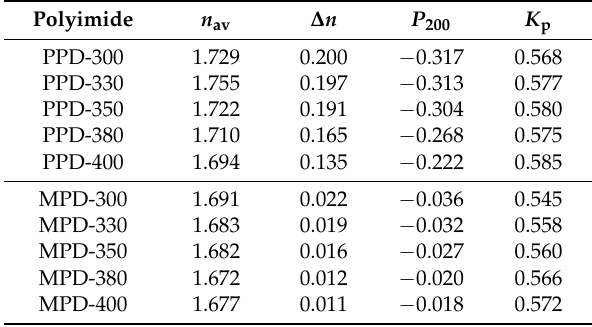
Table 3. Average refractive indices measured at 1310 nm ( n av ), in-plane/out-of-plane